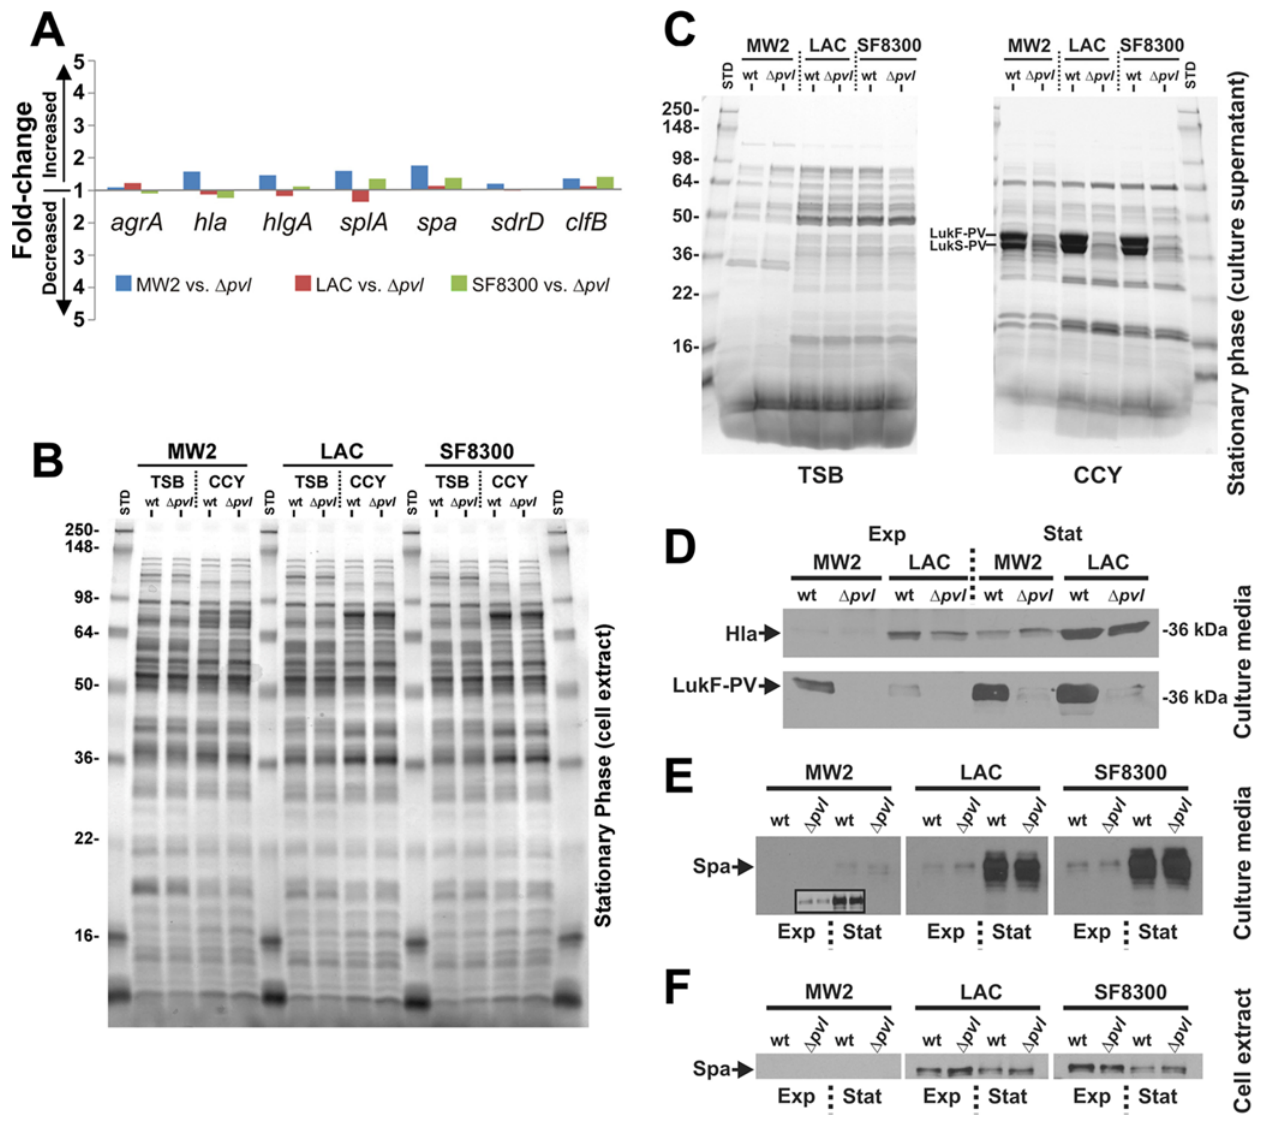
Figure 1. PVL does not alter global gene and protein expression profiles. Clinical strains of USA300 (LAC and SF8300) and USA400 (MW2) and their respective isogenic D pvl mutant strains were cultured to mid-exponential or stationary phases of growth in TSB or CCY media. (A) TaqMan real-time RT-PCR for comparison of fold changes in transcript levels of selected Agr-regulated genes in wild type and D pvl mutant strains. See also Table 2 for additional data derived from in vitro growth to exponential phase and stationary phase in CCY or TSB media. agrA , accessory global regulator; hla , alpha-toxin; hlgA , gamma-haemolysin component A; splA , serine protease; spa , protein A; sdrD , serine aspartate repeat protein; clfB , clumping factor B. (B) Cell extracts separated by 12% SDS-PAGE (Protean II gel, Bio-Rad) using cultures grown to stationary phase. (C) Culture supernatants, prepared from growth in TSB or CCY media, were separated by gradient 10-20% SDS-PAGE. PVL subunits were identified by automated-direct infusion tandem mass spectrometry [32]. (D, E, F) Western immunoblot analysis of supernatants and cell extracts from cultures grown to stationary or mid-exponential phase. Proteins were detected with rabbit polyclonal antibodies specific for LukF-PV, Hla ( a -toxin), or Spa. The immunoblots in panel E were exposed on the same film for equal times or using a longer exposure for MW2 (inset), which produced less Spa. Protein samples for SDS-PAGE presented in panels B and C were prepared in a manner identical to those shown in panels E and F.